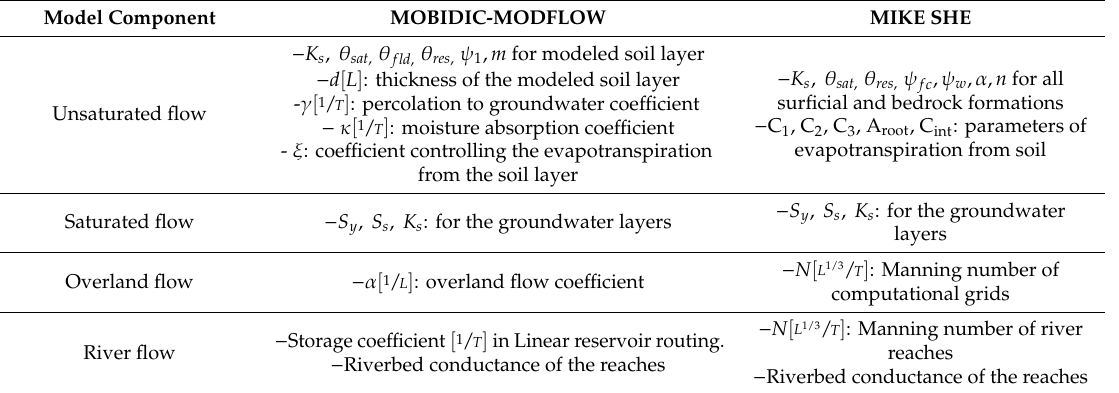
Table 2. List of input parameters for MOBIDIC-MODFLOW and MIKE SHE. The detailed definition of the parameters for MOBIDIC-MODFLOW and MIKE SHE are given in [14,24], respectively. Model Component MOBIDIC-MODFLOW MIKE